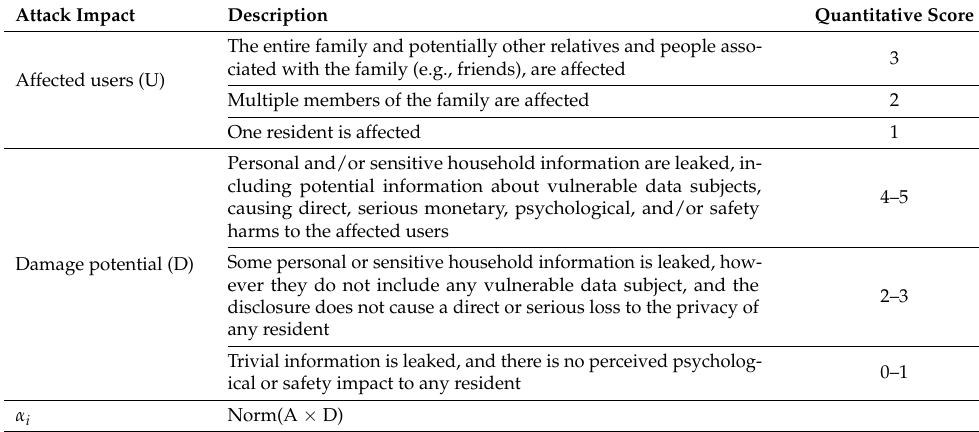
Table 6. Guidelines for grading the attack impact ( α i ).